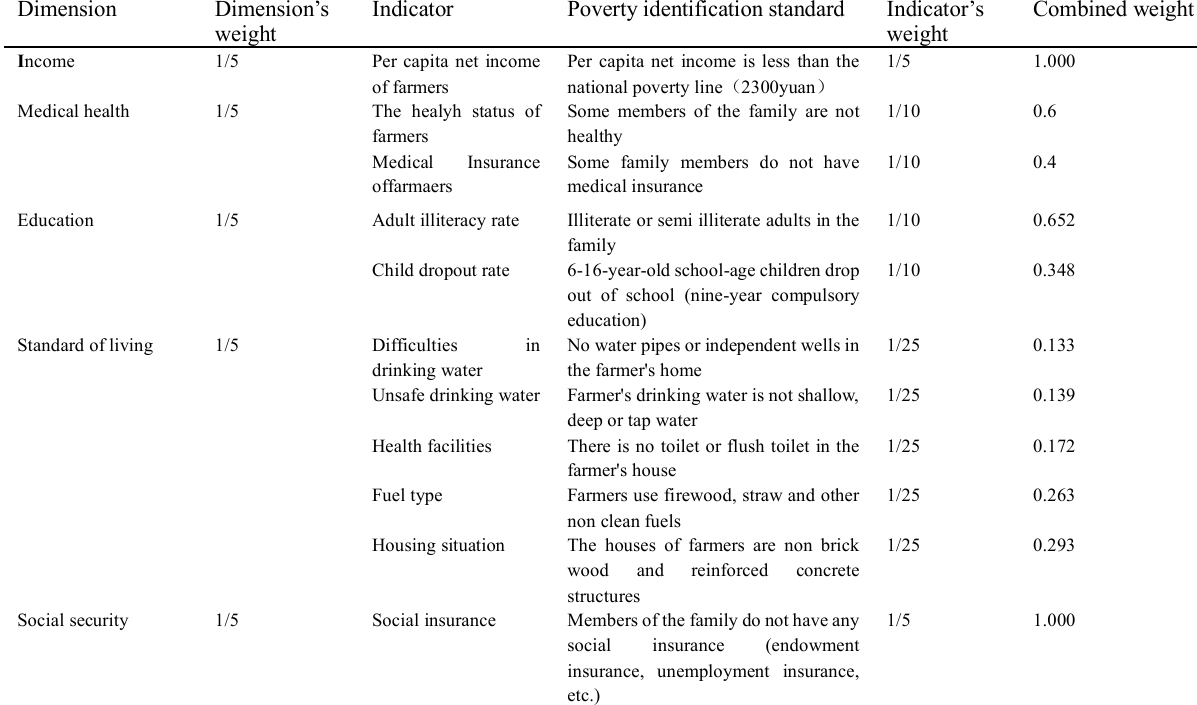
Table 2. Multidimensional poverty measurement index and their corresponding